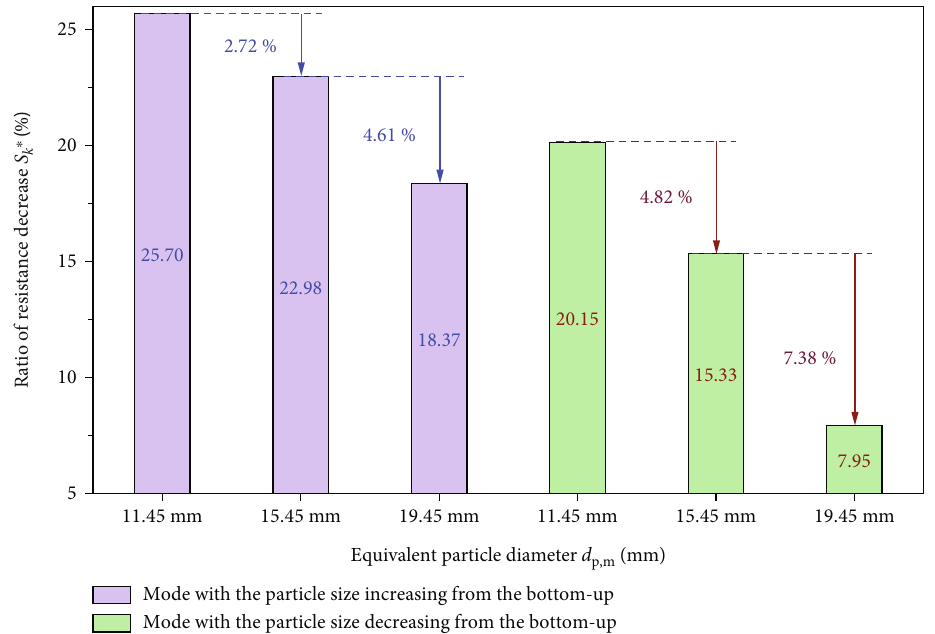
Figure 14: E ff ect of the equivalent particle diameter d arrangement